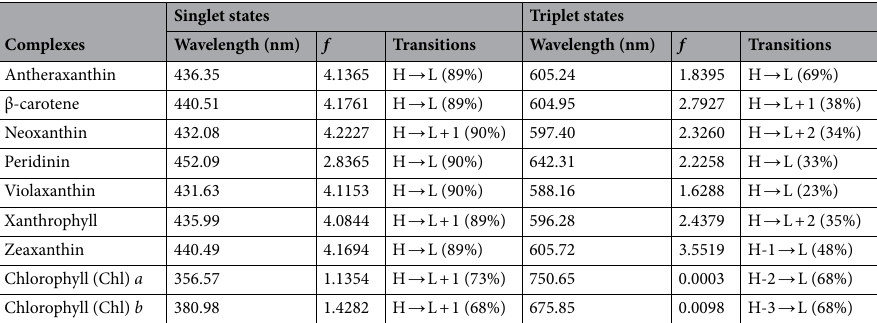
Table 3. Absorption wavelength (nm) (Singlet states and Triplet states), Oscillatory Strength ( f ) and transitions for studied carotenoids (wB97xD/6-31G**) and Chlorophyll (wB97xD/Lanl2dz:6-31G**) by TDDFT in solvent (water) medium.